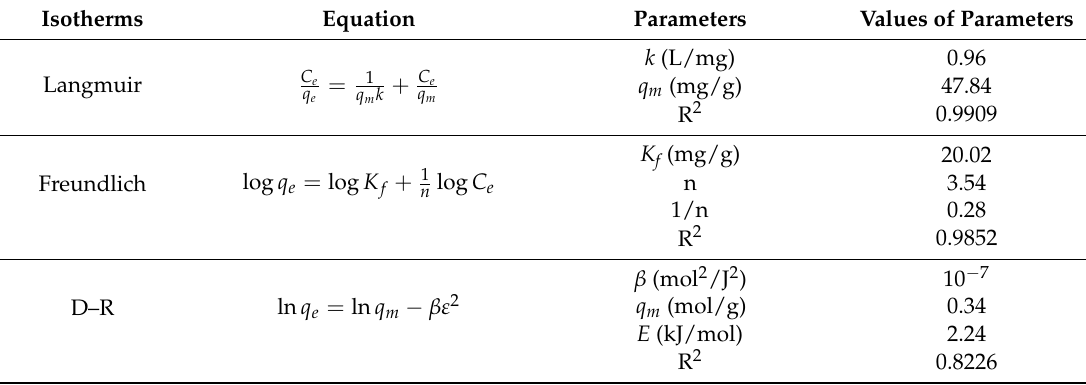
Table 6. Parameters of isotherm models for the adsorption of Cd(II) onto the nZVI/rGO composites. Isotherms Equation Parameters Values of Parameters